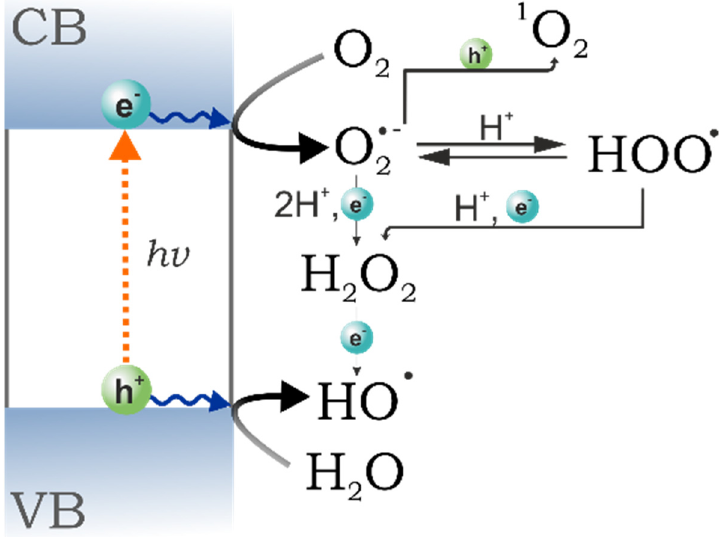
Figure 22. Schematic mechanism of photocatalytic formation of ROS from [268] with permission of American Chemical Society.